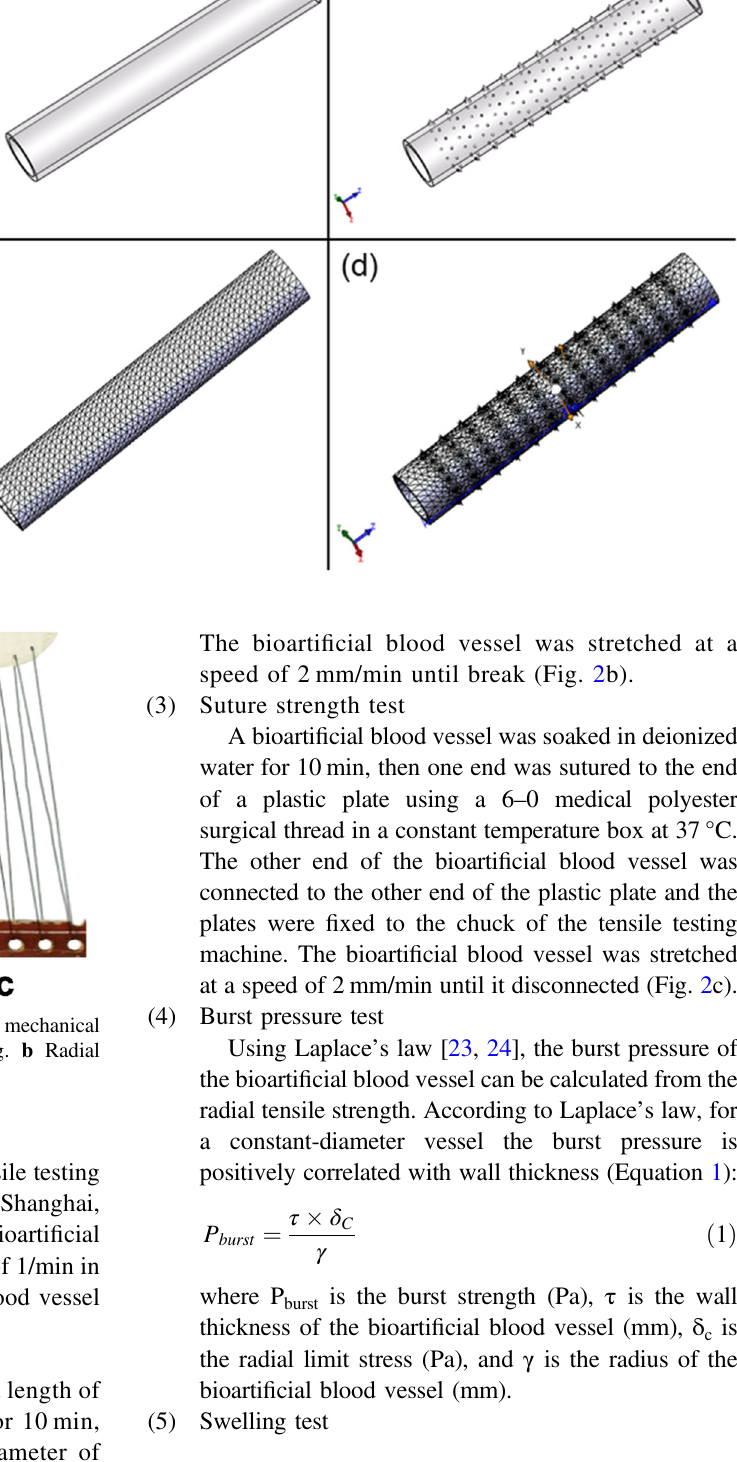
Fig. 1 Modeling of bioarti fi cial blood vessels without and with thorn-like protrusions: a Model of a bioarti fi cial blood vessel without thorn-like protrusions. b Model of a bioarti fi cial blood vessel with thorn-like protrusions. c Mesh of